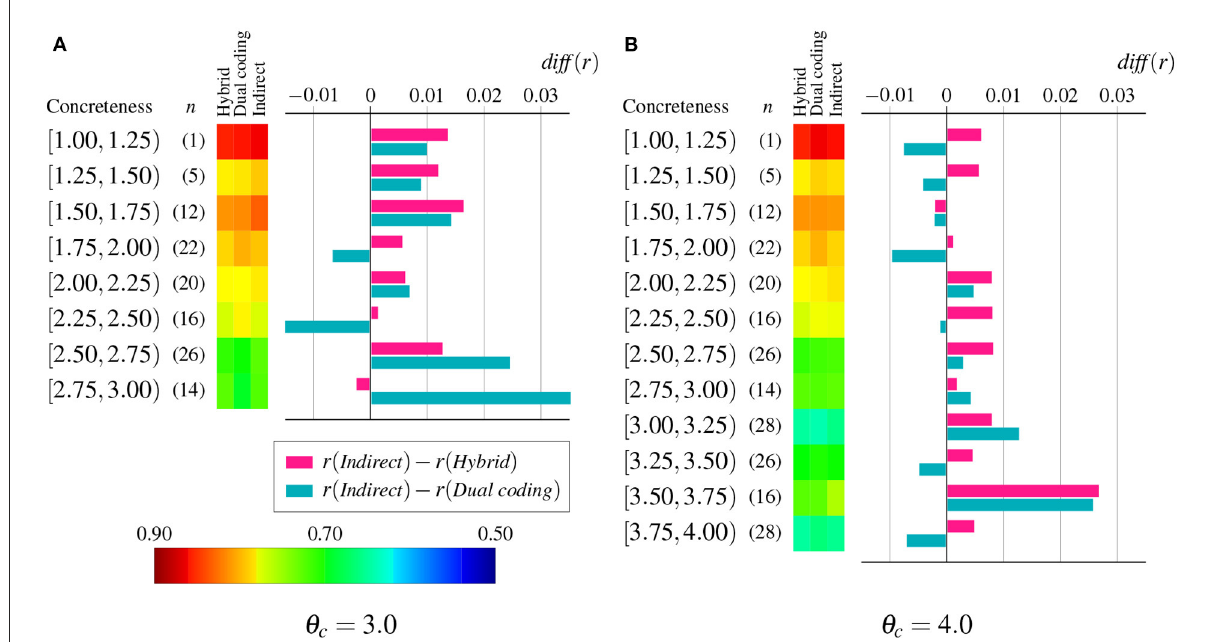
FIGURE5 Mean difference of correlation diff ( r ) between the indirect grounding model and two competing models per each of the equally divided intervals of concreteness. The heatmap depicts the mean correlation of hybrid, dual coding, and indirect grounding models. Numbers in parentheses denote the number of words n within an interval. Red and blue graphs, respectively, denote the degree of improvement against the hybrid model and the dual coding model. (A) θ c = 3.0. (B) θ c =